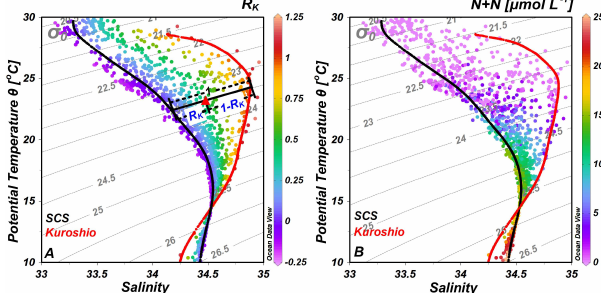
Fig. 6. Potential temperature ( θ ) versus salinity ( S ) plots ( θ - S di- agram) in the upper 400m of the water column for the sampling stations in the central northern South China Sea (NSCS) superim- posed by (A) the isopycnal mixing model-derived Kuroshio water fraction ( R K ), and (B) the field observed N + N (nitrate plus ni- trite) concentrations. A red triangle in (A) donates an example of the R K calculation along the potential density 1023.5 surface. Data of the typical Kuroshio water were collected from LU6 section in spring, while data of the SCS proper water were collected from sta- tion SEATS and its nearby stations in